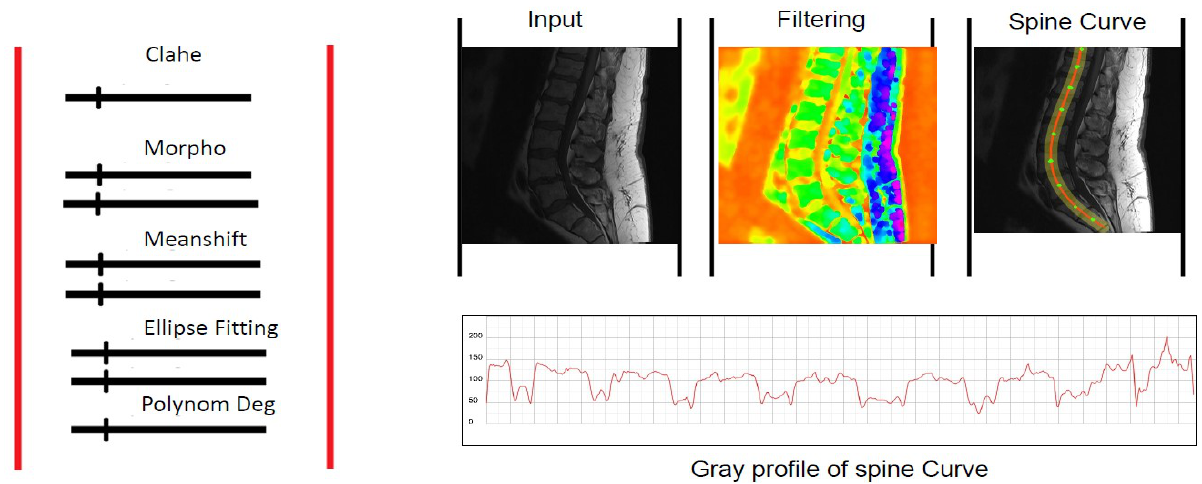
Figure 6 | Illustration of the functionalities of the advanced services with the expected